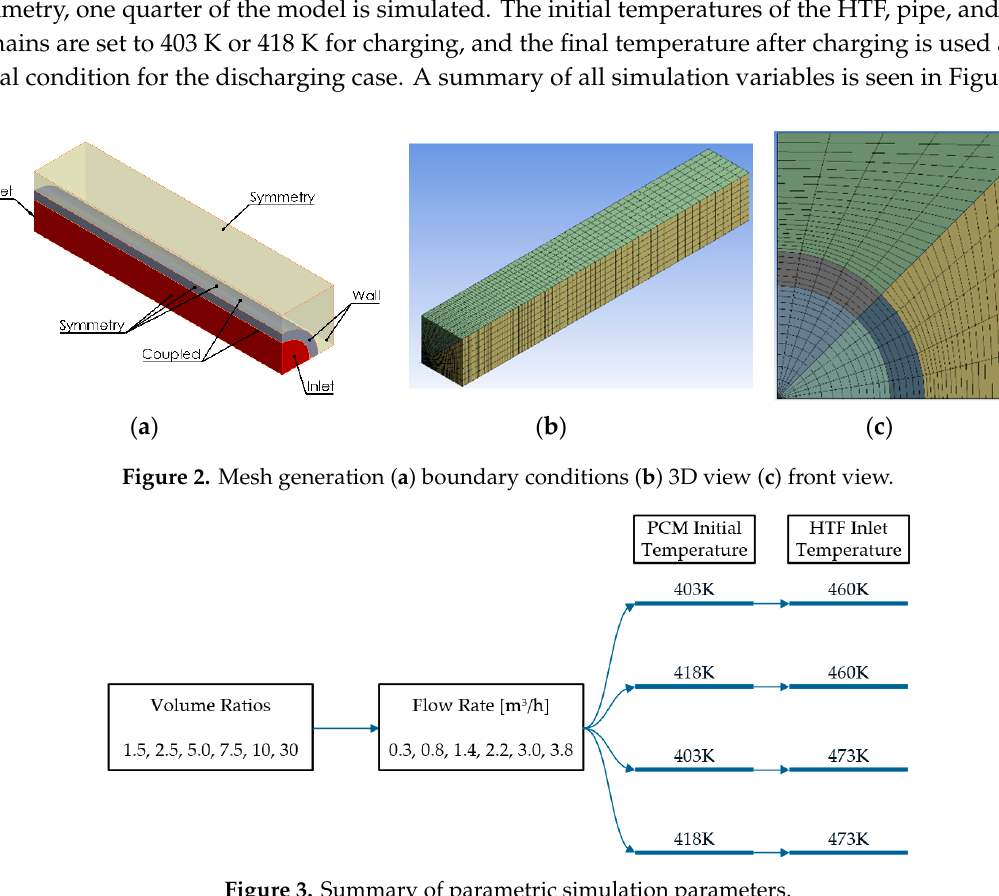
Figure 4. Independence tests ( a ) Grid size ( b ) Time step size